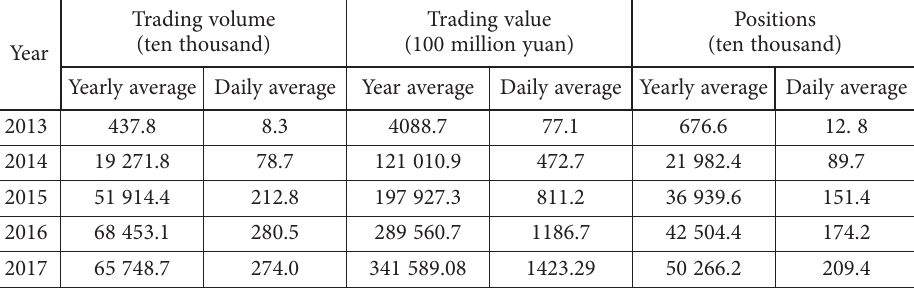
Table 3. Iron ore futures trading volume, trading value and positions for the